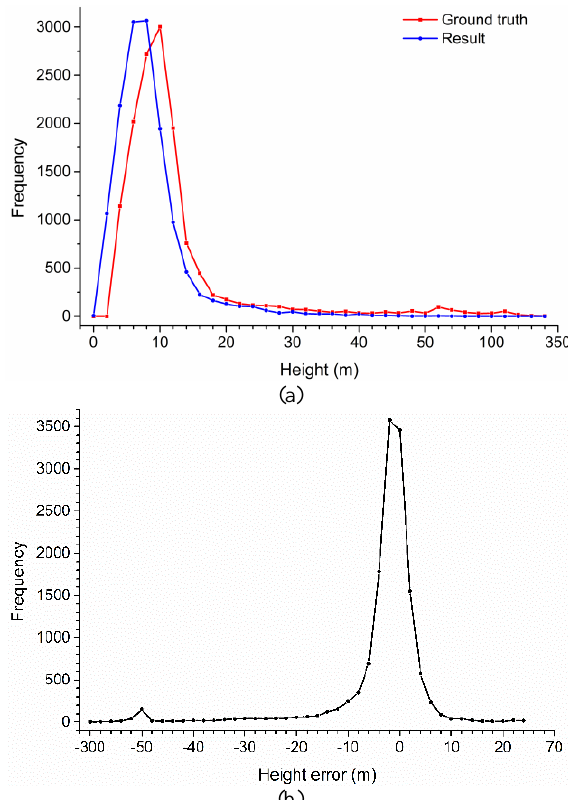
Figure 4. Distributions of building height values and errors. (a) Building height value distribution comparison between result and ground truth. (b) Building height error